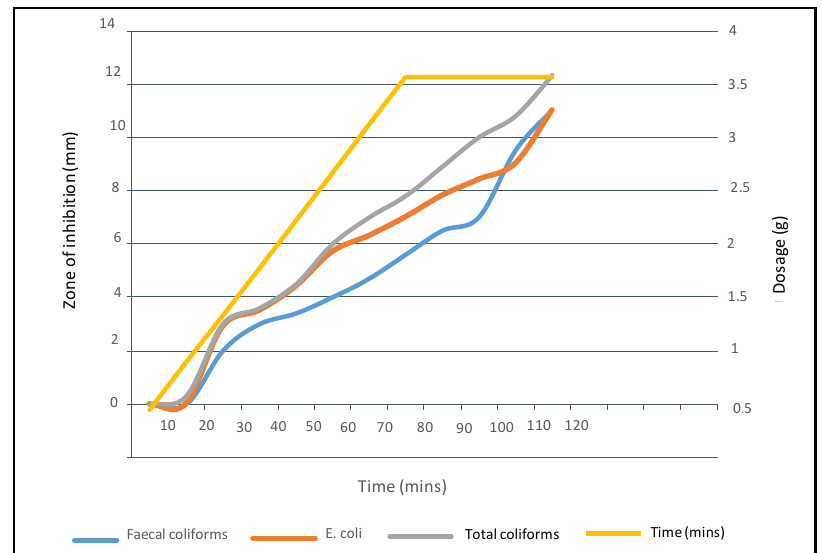
Figure 3. The dosage of sunflower seed extract required to eliminate indicator bacteria per given time intervals and the resultant zone of inhibition.